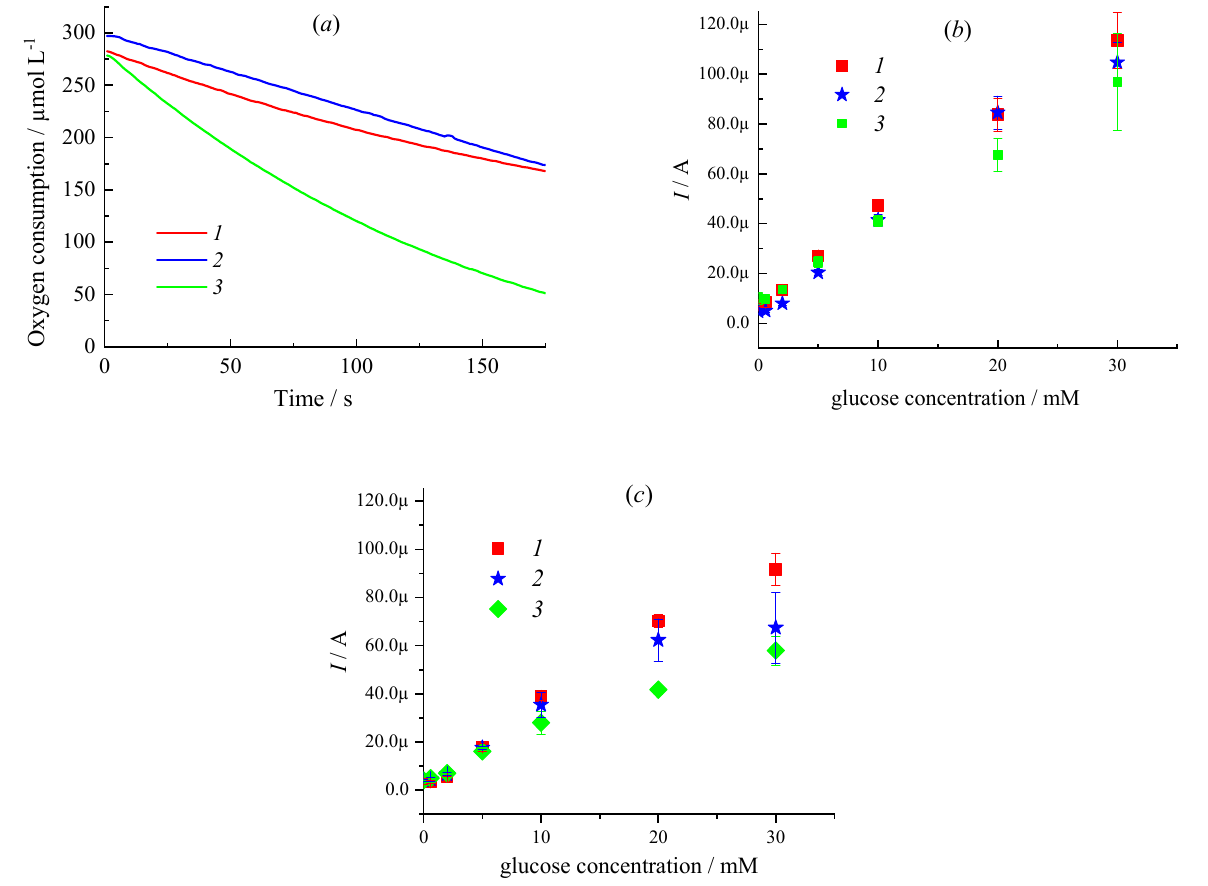
Figure 2. ( a )–The response of the optical oxygen microsensor expressed as the number of moles ( µ mol/L) of the dissolved oxygen present in 100 mM glucose solution and 100 µ L of 0.1 mg/mL GOx; ( b , c )—calibration curves obtained from 10CMC/25ALG/200FC/24GOx ( b ) and 10CMC/50AS/200FC/24GOx ( c ) test-strips in different buffer solutions. Note: 1–citrate buffer (CitB, pH = 6); 2–phosphate buffer (PPBI, pH = 7.1); 3 – acetate buffer (AcB, pH = 5.5).